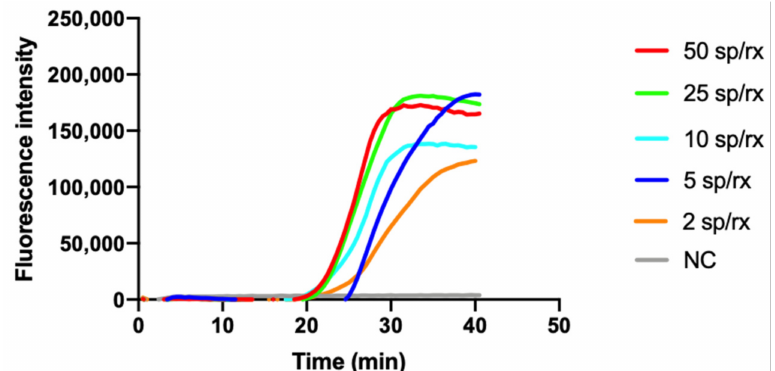
Figure 2. Representative SYBR Green-based real-time fluorescence detection of C. tyrobutyricum spores in water at decreasing concentrations of spores/reaction (sp/rx). NC: negative control. All experiments were performed in quadruplicate, each being repeated at least three times.